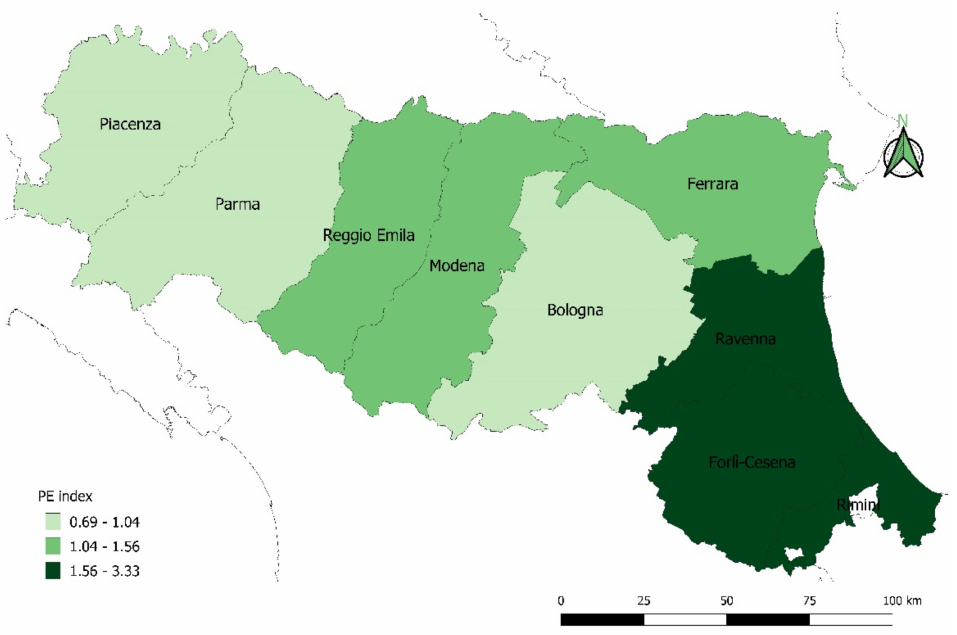
Figure 3. PE index distribution at the territorial level within the Emilia-Romagna